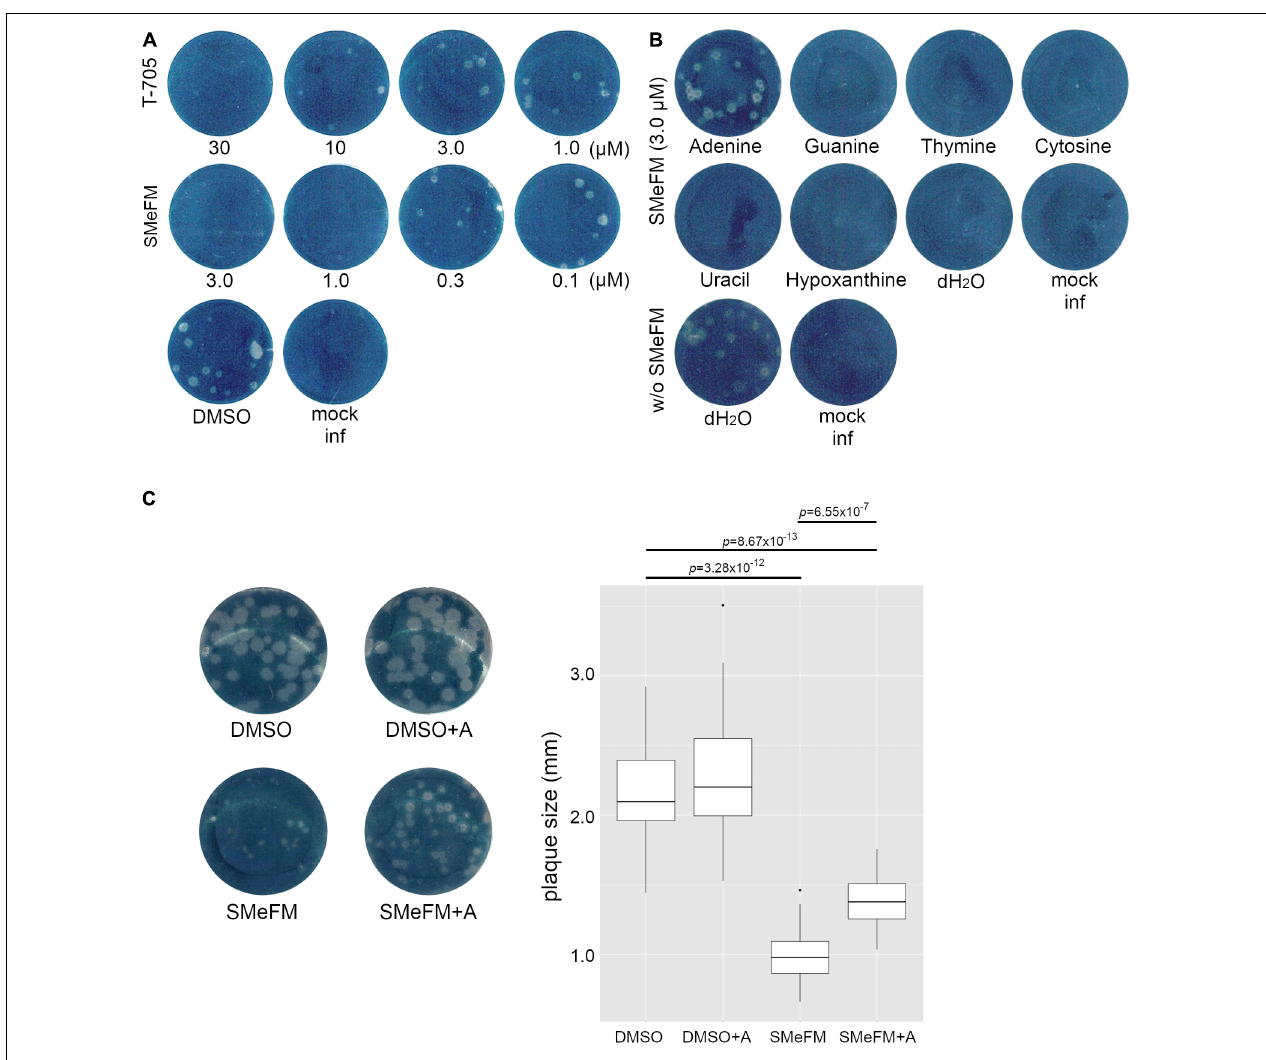
FIGURE 5 | The addition of adenine attenuates the inhibitory effect of SMeFM on viral propagation. (A) Inhibition of plaque formation by SMeFM. MDCK cells were infected with the influenza A virus (WSN strain, 20 PFU) and were overlayed with MEM-0.8% agarose containing SMeFM or T-705. After 48 h incubation, the cells were fixed and stained by amido black. (B) Plaque assay with SMeFM and nucleobases. MDCK cells were infected with the influenza A virus (20 PFU) and were overlayed with MEM-0.8% agarose containing 3 µ M SMeFM and an indicated nucleobase (20 µ M). (C) The plaque size with SMeFM and adenine. The plaque of infected cells overlayed with agarose containing DMSO, both DMSO and 20 µ M adenine, 1 µ M SMeFM, or both SMeFM and adenine (left panel). The plaque size incubated with DMSO, both DMSO and adenine, SMeFM, or both SMeFM and adenine ( n = 30, 30, 18, and 32, respectively) was measured and plotted (right panel). P -values were calculated by Wilcoxon rank sum test and were corrected by Bonferroni